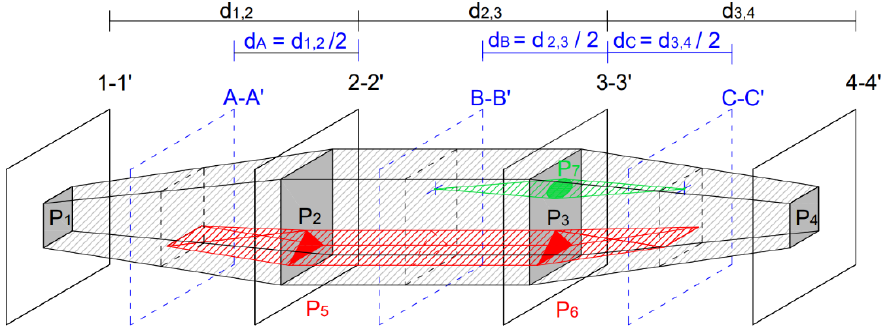
Figure 4. Sketch for volume calculation principle using geological sections.